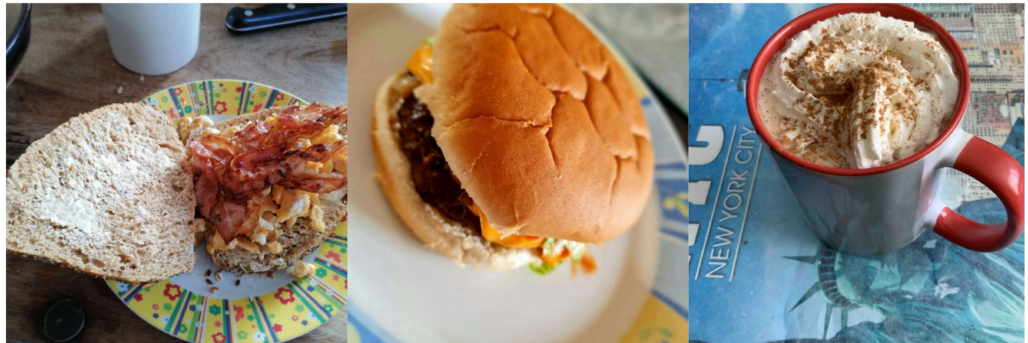
Figure A5. Meal photos at the start of the study.